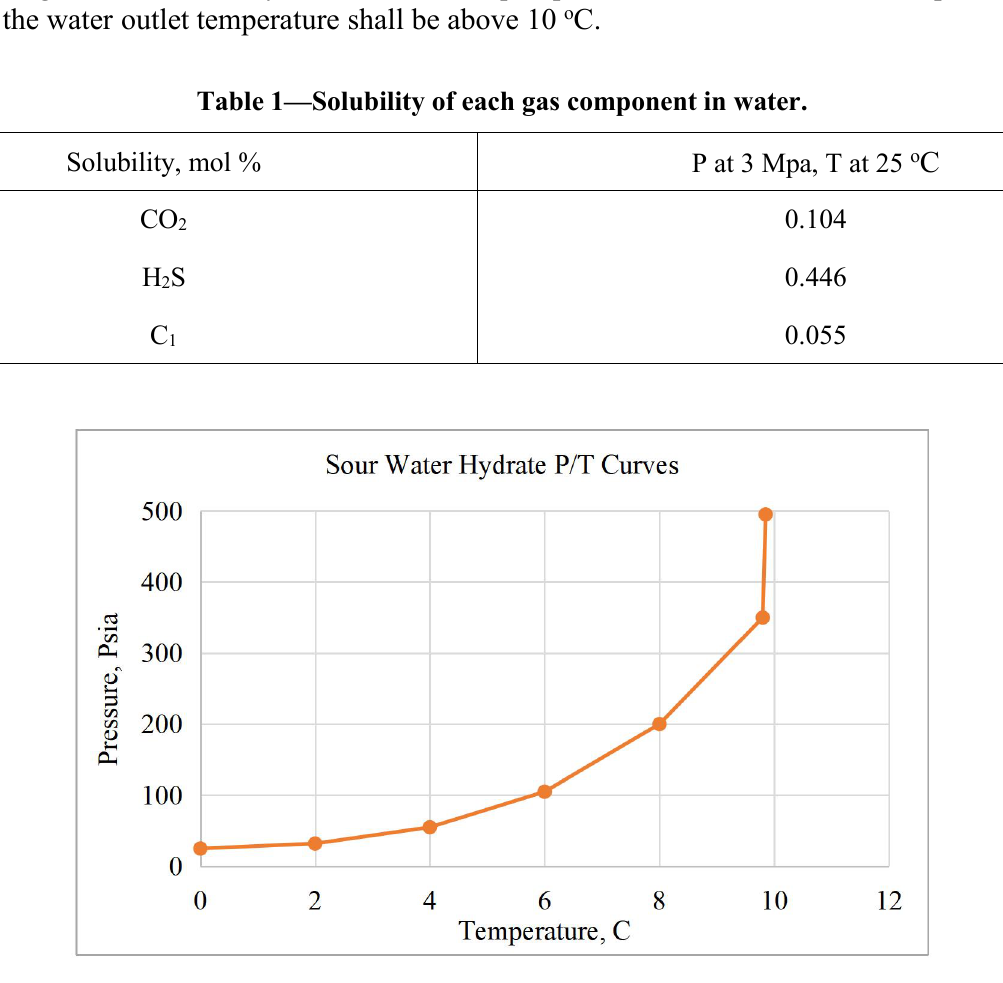
Figure 9—Hydrate P/T curve for sour water without MEG